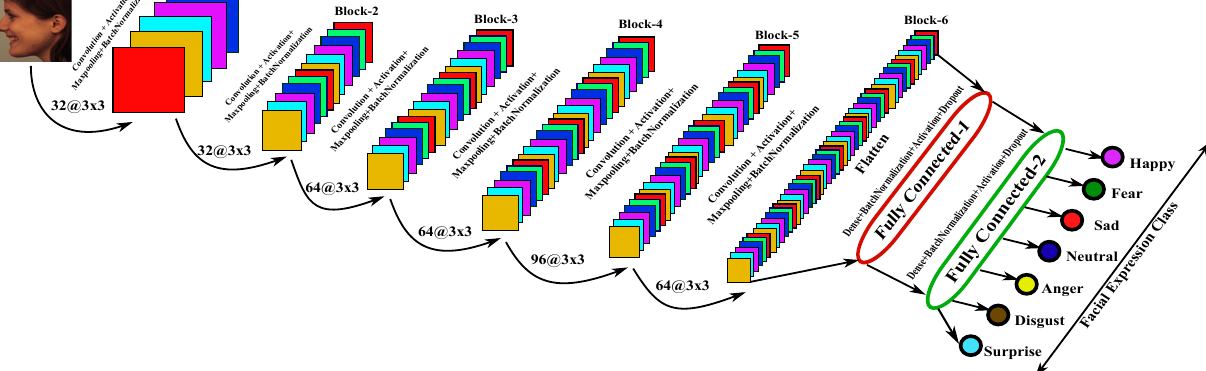
Figure 5. CNN 2 architecture for the proposed FER system, that takes the input image F of size ( n 2 × n 2 × 3 ) .